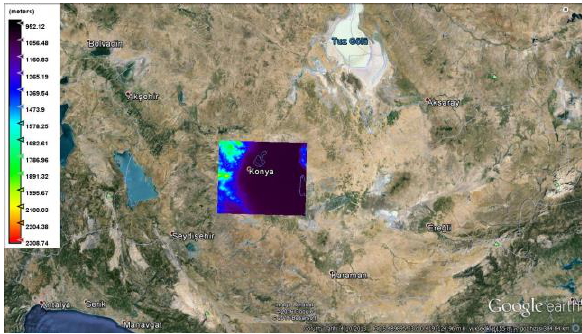
Figure 2. Elevation Map and Legend on Test